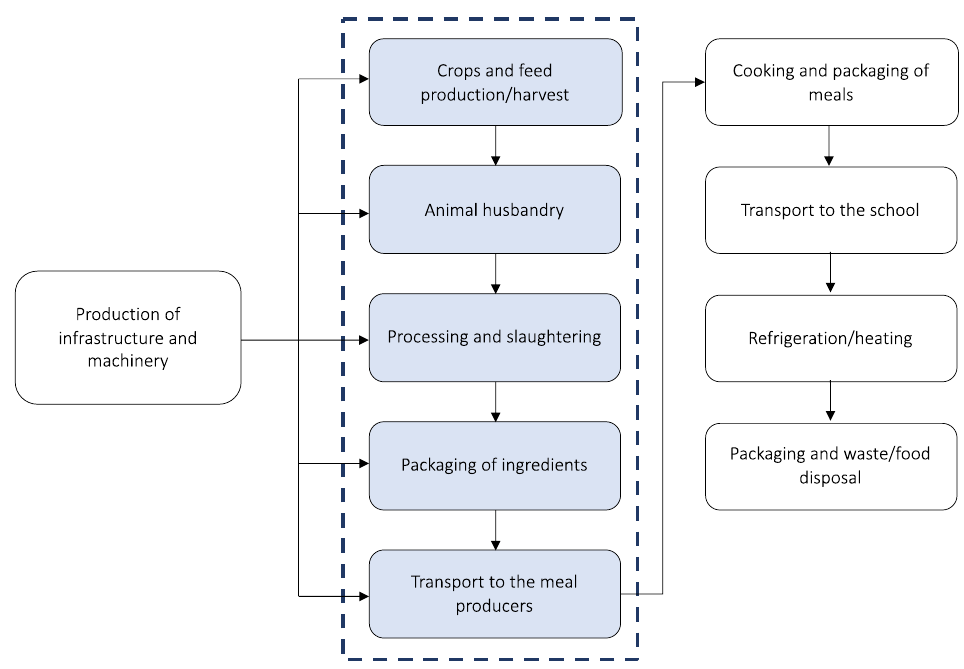
Figure 1. System boundaries of the study: from-cradle-to-gate approach.